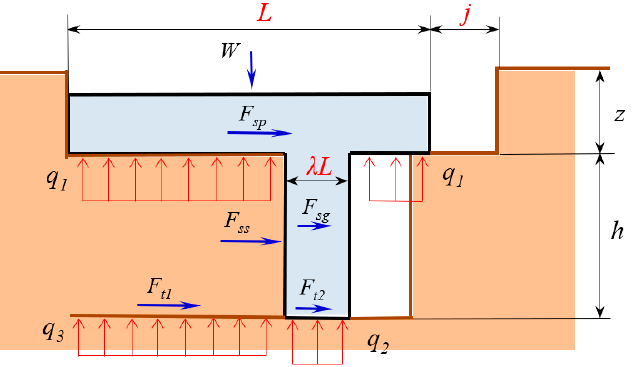
where q 1 is the contact pressure of the spacing surface of the track plate and q 2 is the pressure at the tip surface of the track grouser.